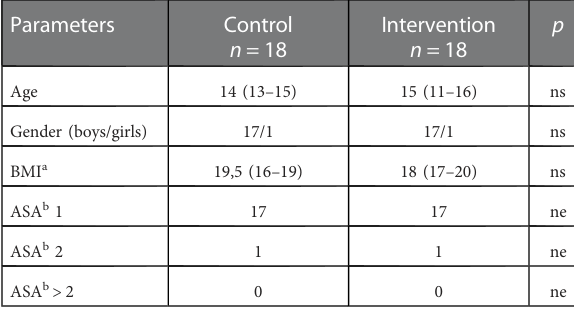
estimable; quantitative data: median and